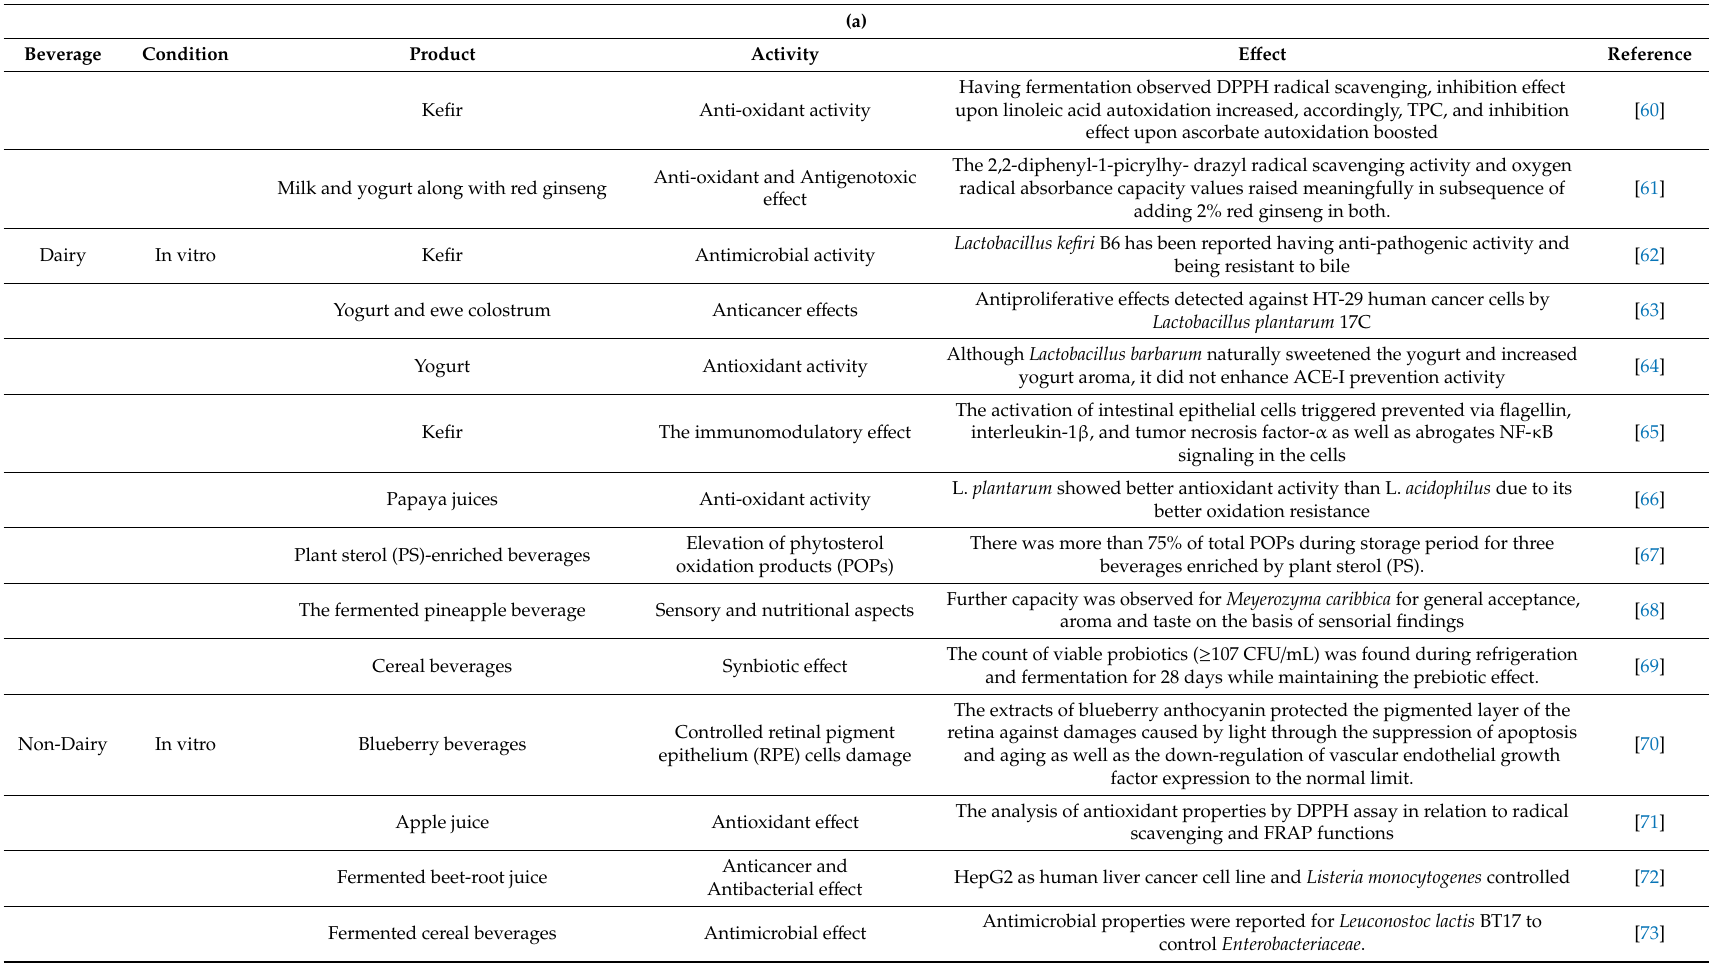
Table 1. ( a ) In vitro studies; ( b ) in animal studies; ( c ) in human studies.